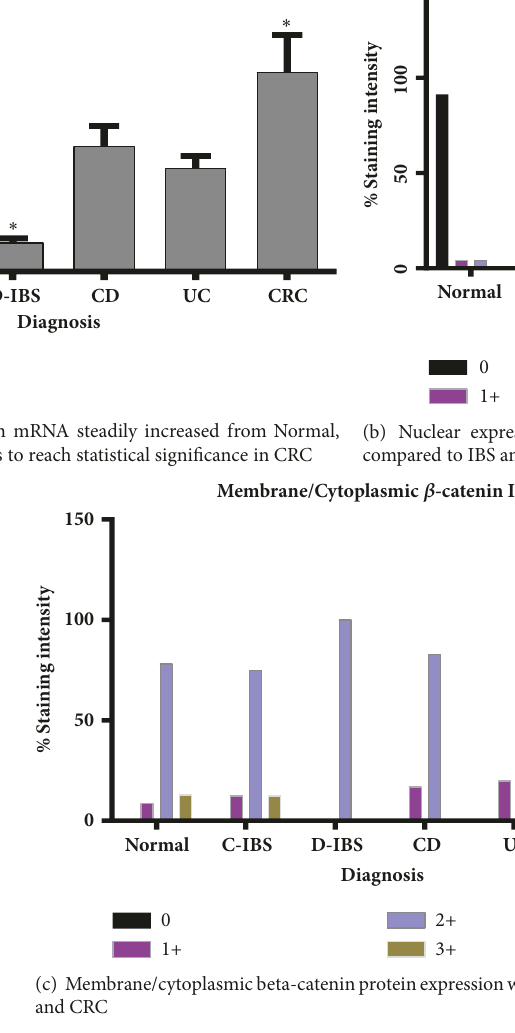
Figure 1: 𝛽 -catenin expression. (a) 𝛽 -catenin mRNA expression. CNRQ = Calibrated Normalized Relative Quantities, normalized to mean for all samples. Total patient number studied = seventy-five (75) with Normal group: seventeen (17) patients, C-IBS group: twenty-two (22) patients, D-IBS group: eight (8) patients, CD group: six (6) patients, UC group: eight (8) patients, and CRC group: sixteen (16) patients. ∗ denotes significant different versus normal group (p < 0.05). (b) 𝛽 -catenin nuclear expression and (c) 𝛽 -catenin membrane/cytoplasmic